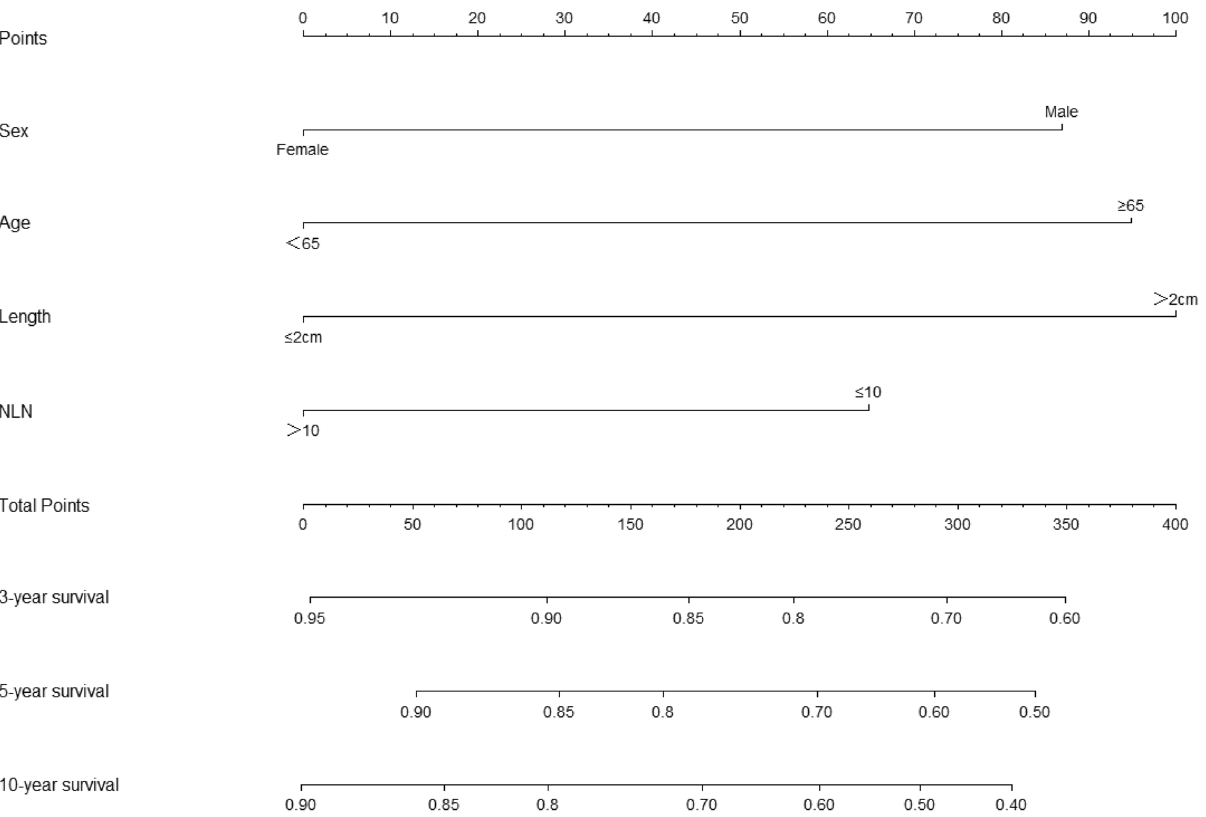
Figure 2. Nomogram predicting the 3-,5- and 10-year OS rates from the training